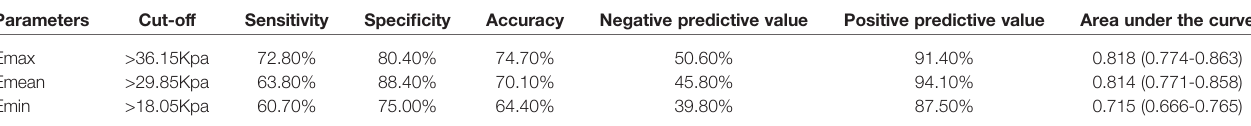
TABLE 2 | Diagnostic ef fi ciency of the SWE parameters.